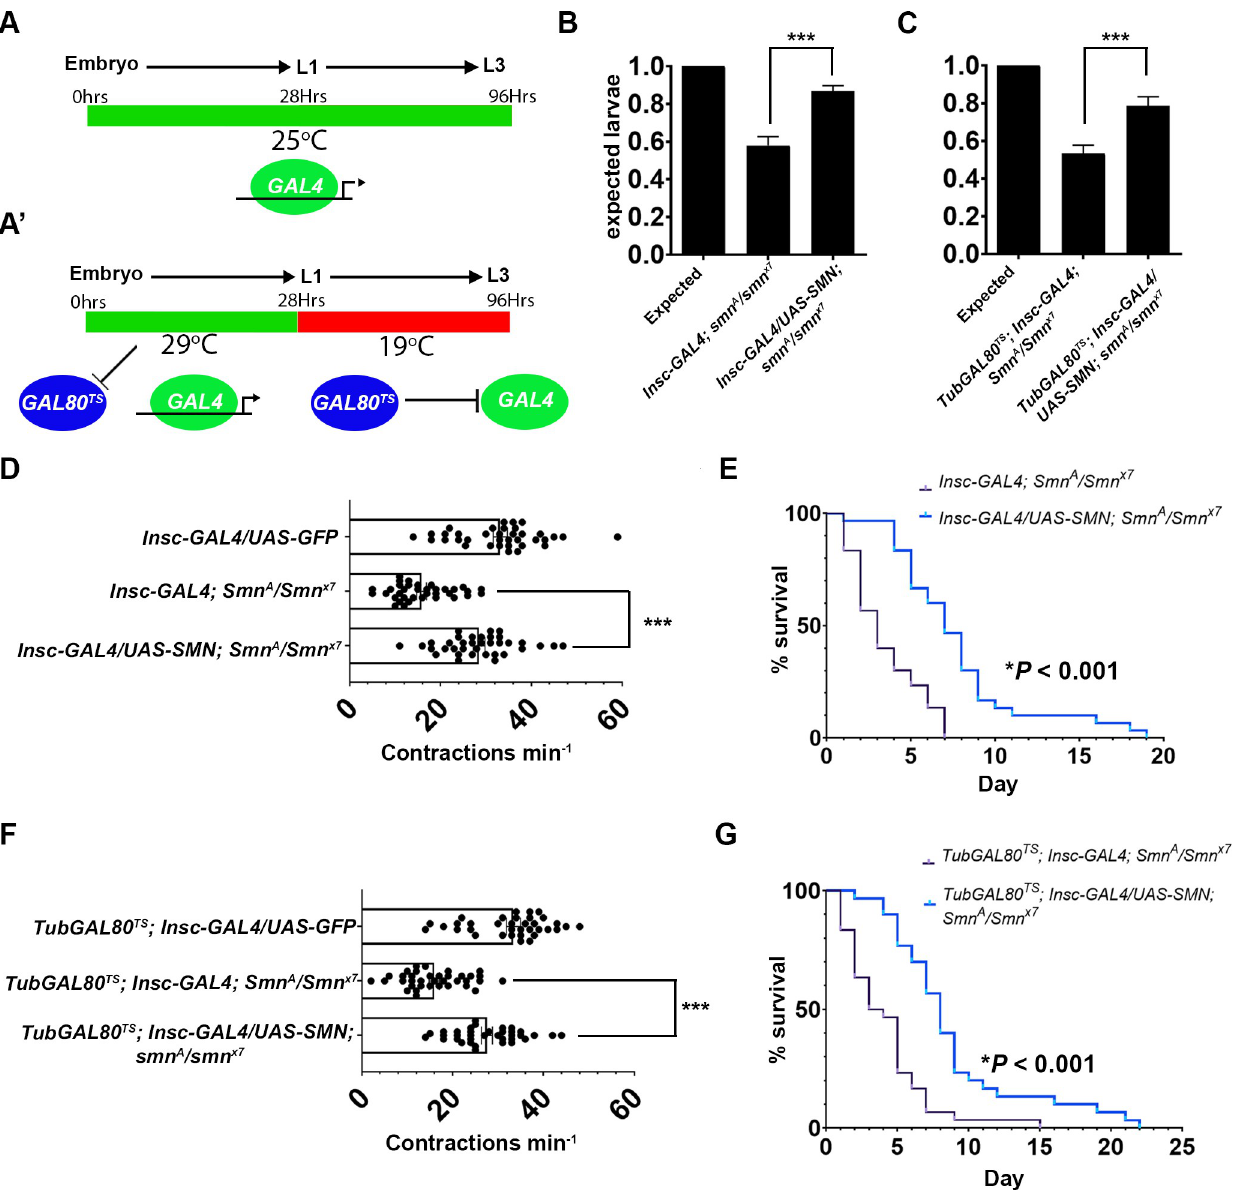
Fig 5. Restoration of survival motor neuron (SMN) in neurogenic cell types rescues the motor phenotypes in Smn mutant larvae. For rescue studies, both the classical binary GAL4 system (A) and the GAL80 TS system (A’) were used. For targeting, a temperature sensitive GAL80 (GAL80 TS ) represses GAL4 at 19˚C but becomes inactive at 29˚C. Embryos were reared for 24 h at 29˚C, during which GAL4 is expressed, then switched to 19˚C to eliminate expression. Expression of SMN using Insc-GAL4 rescue the embryonic attrition seen in SMN mutants with both the (B) binary and (C) TARGET GAL80 TS GAL4 systems ( ��� P < 0.001, three experiments for each genotype, each with n = 60; Kruskal–Wallis test with Dunn’s multiple comparisons); (D) Insc- GAL4/UAS-SMN ; Smn A / S mn x7 larvae show significant rescue of locomotor activity at 72 h compared with mutant Insc-GAL4; Smn A / Smn x7 ( ��� P < 0.001, n = 15, Kruskal–Wallis test with Dunn’s multiple comparisons); (E) larval survival was extended from a median of 3 days to a median of 7 days (three experiments for each genotype, each with n > 30; ��� P < 0.001; Mantel-Cox); (F) Tub-GAL80 TS ; Insc-GAL4/UAS-SMN ; Smn A /Smn x7 larvae display a significant rescue of motor function at 72 h, compared with controls ( ��� P < 0.001, n = 20, Kruskal–Wallis test with Dunn’s multiple comparisons); (G) larval survival was extended from a median of 4 days to a median of 8 days (three experiments for each genotype, each with n > 30; ��� P < 0.001; Mantel- Cox). All error bars